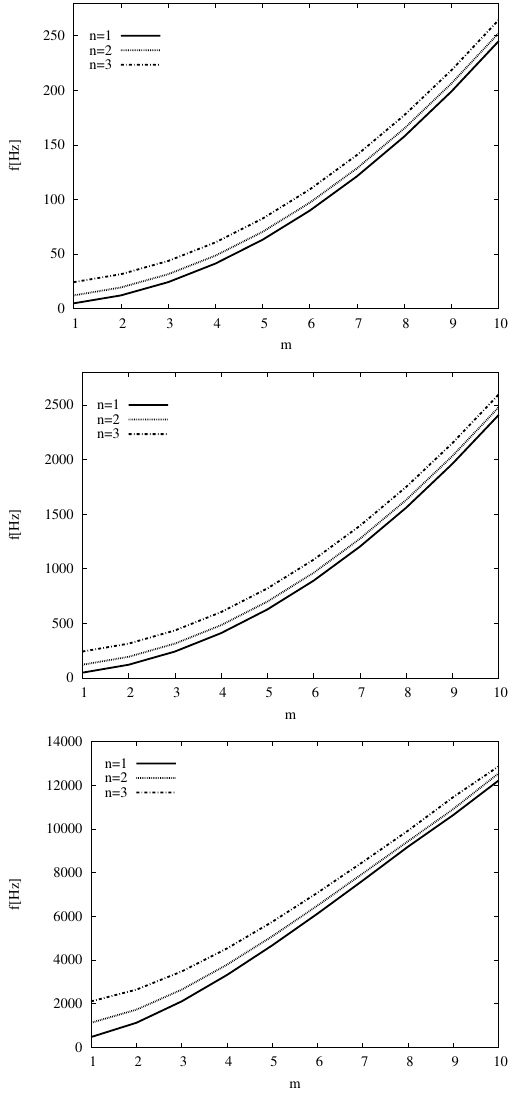
Figure 16: First benchmark, simply supported plate made of alu- minium alloy with thickness ratios a/h=1000 (top), a/h=100 (mid- dle) and a/h=10 (bottom). First (I) 3D frequencies versus half-wave numbers m (from 1 to 10) and n (from 1 to